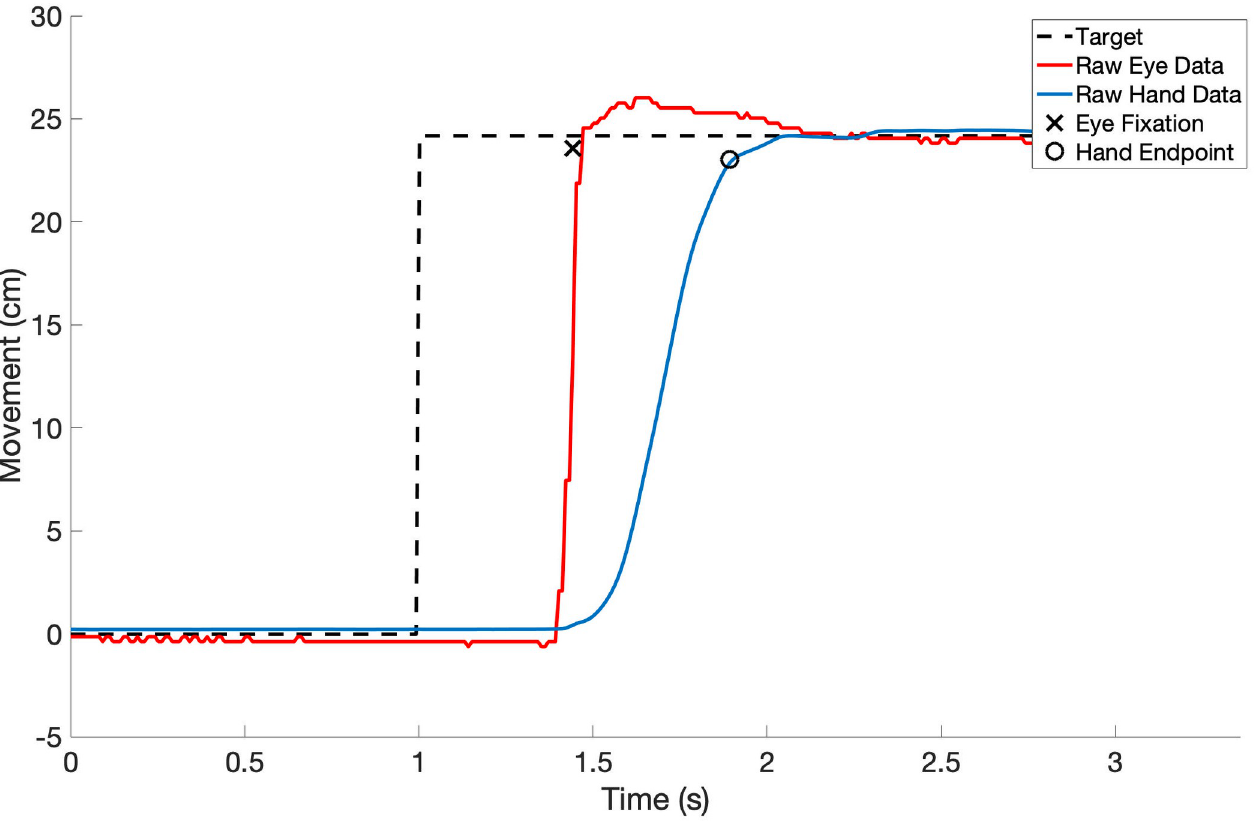
Fig 4. Temporal sequence of events. One trial is defined as movement from the starting target, to the task target, and back to the starting target. Just the movement in the horizontal direction from the starting target to the task target is shown here for one representative trial. A typical trial sequence consisted first of the task target appearance, followed by the eye fixation, followed by the hand